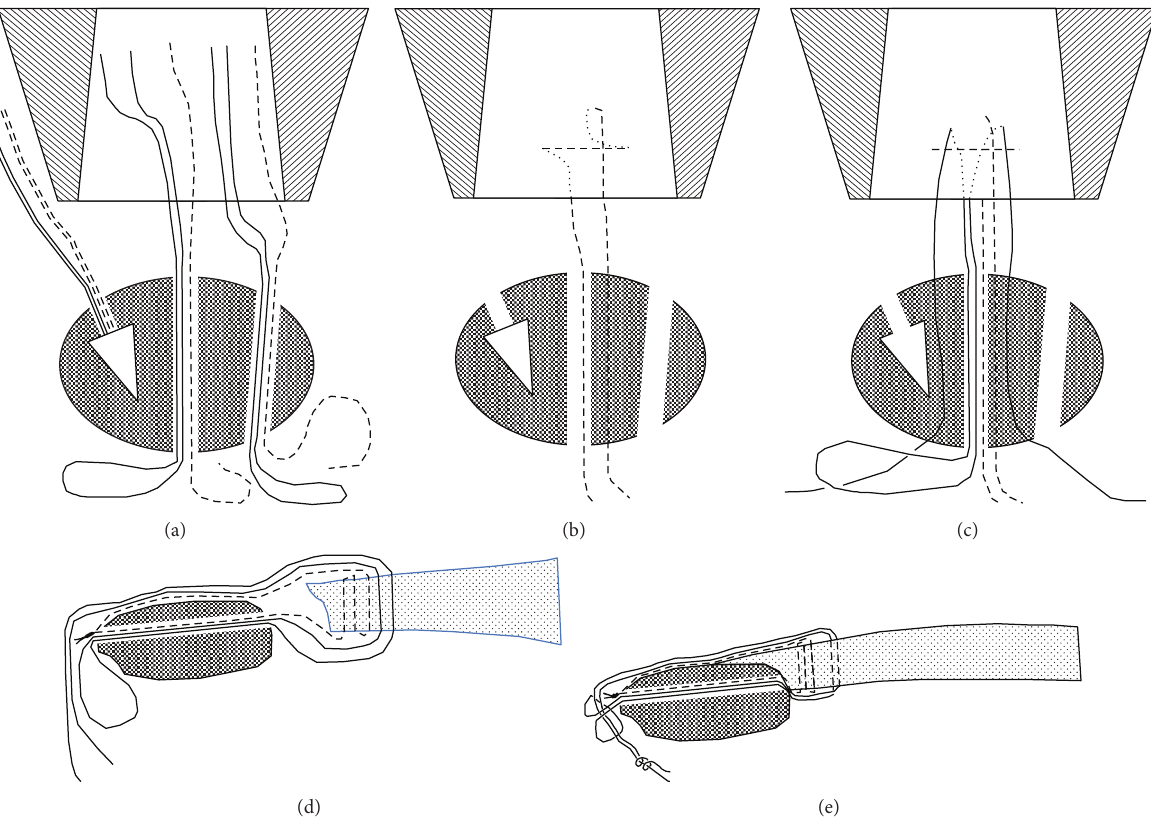
Figure 7: Schema for the arthroscopic suture in Case 1. (a) Two threads (a dotted line for the Mason–Allen method and a solid line for the double-loop sliding knot) were used for the central and lateral bone tunnels. (b) The thread (dotted line) in the central bone tunnel holding the tendon by the Mason–Allen method was passed through the anterior region and inside of the tunnel of the patella and was pulled out to the patellar lower rim. (c) The thread (solid line) holding the tendon over and proximal to the roof of the Mason–Allen method was next passed through the anterior region and inside of the tunnel of the patella and was pulled out to the patellar lower rim. The procedures used in (b) and (c) were also performed in the lateral bone tunnel. (d) and (e) Each thread gathered at the patellar lower rim was tied.